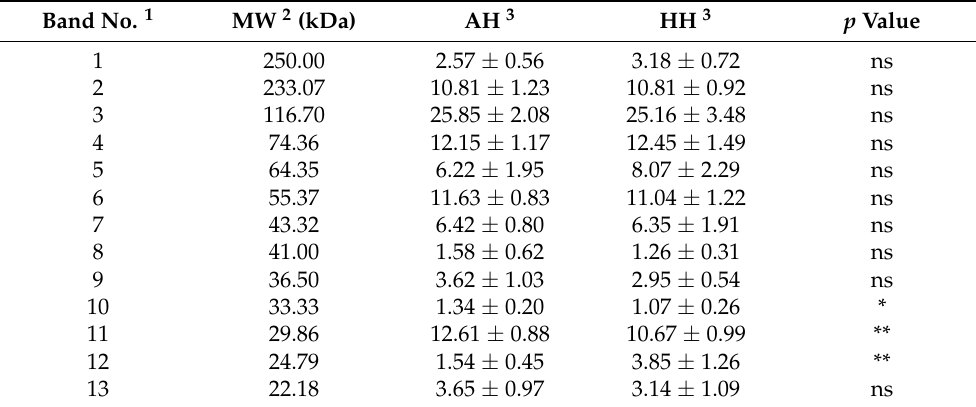
Table 5. Densitometric analysis of electrophoretic bands visualized through the sodium dodecyl sulfate polyacrylamide gel electrophoresis (SDS-PAGE) of globular proteins extracted from egg yolks obtained from commercial hybrid hen (HH) and Nera Atriana laying hen